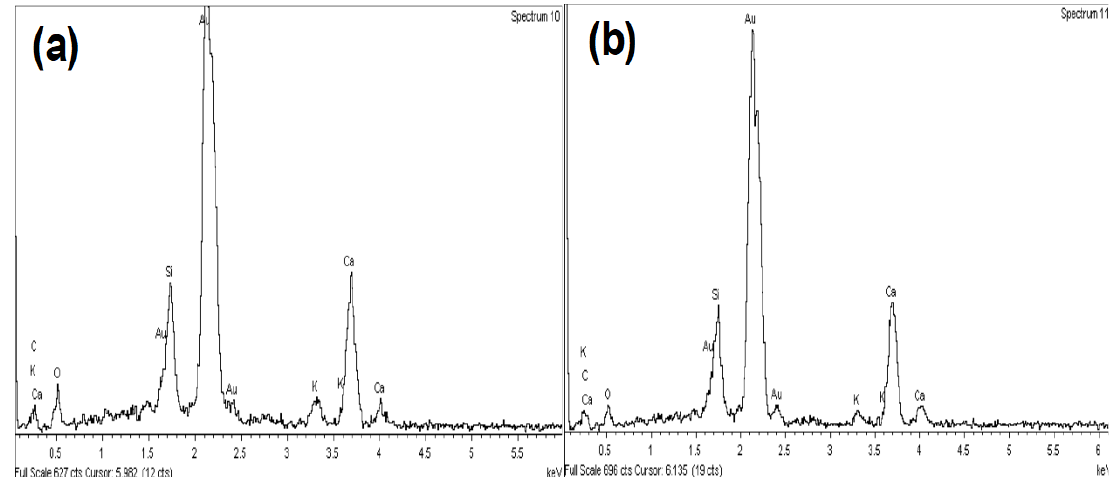
Figure 8. Chemical composition obtained by EDS (a) Figure 7d and (b) Figure